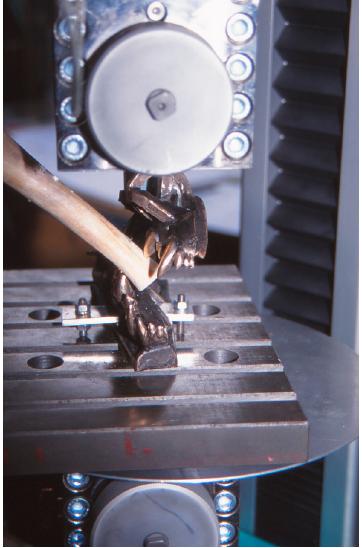
Figure 2. Experimental piercing of a fresh femur of a young brown bear using a bronze model of hyena’s dentition and the ZWICK/Z 050 machine for measuring compressive force (photo Ivan Turk, ZRC SAZU).